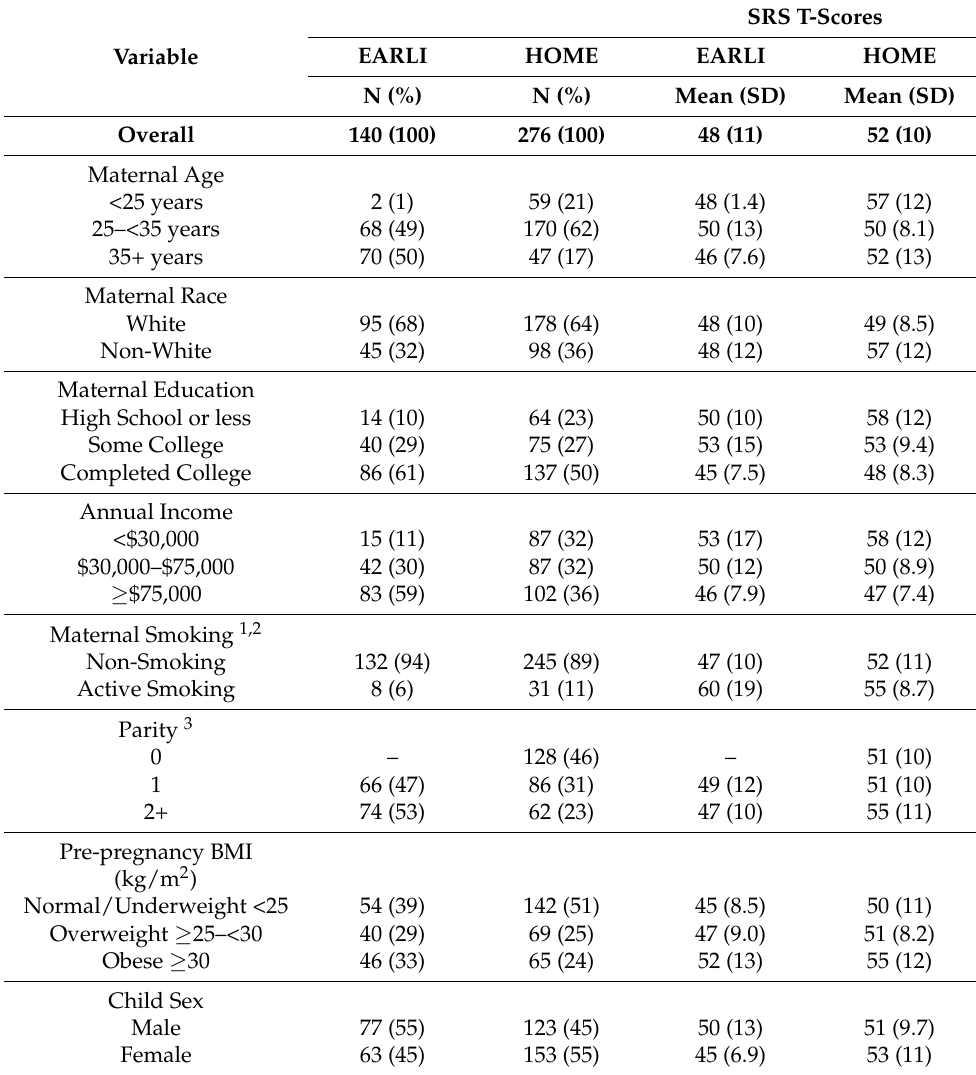
Table 1. Study sample characteristics and mean child Social Responsiveness Scale (SRS) total T-Scores at 3 to 8 years according to covariates: the EARLI (2009–2012) and HOME Studies